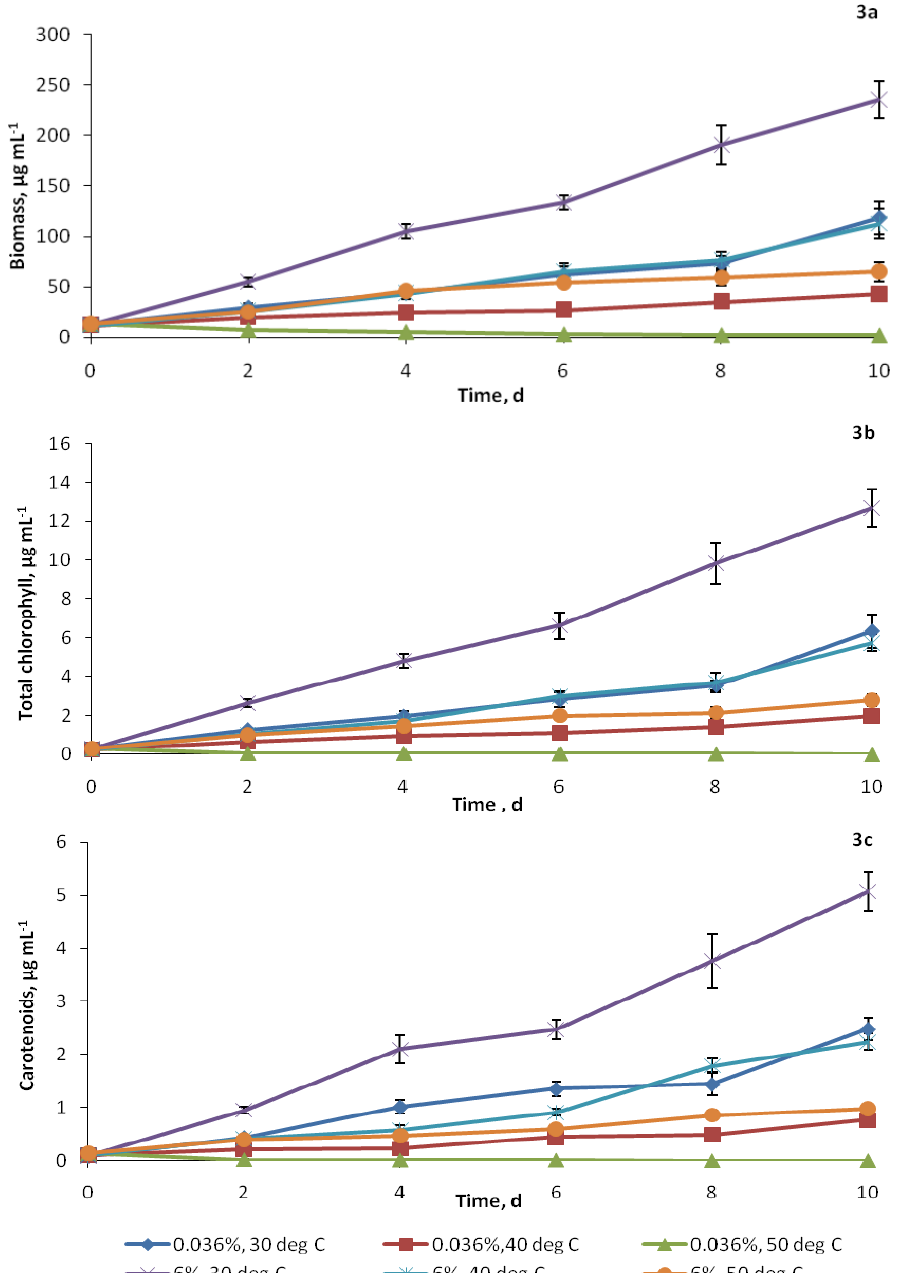
Figure 3. Effect of elevated CO and temperature on (a) biomass, (b) total chlorophyll and 2 (c) carotenoid contents (µg mL -1 ) of C. vulgaris